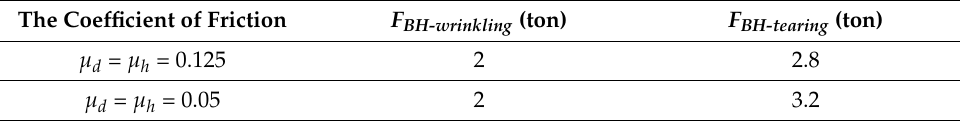
Figure 9. Variation in wrinkling formation as a function of blank holder force ( F BH ) and maximum deep drawing force ( F d-max ) at μ h = μ d = 0.05. Table 3. The values of the wrinkling and tearing forces at different friction coefficients. The Coefficient of Friction F BH-wrinkling (ton) F BH-tearing (ton) µ d = µ h =